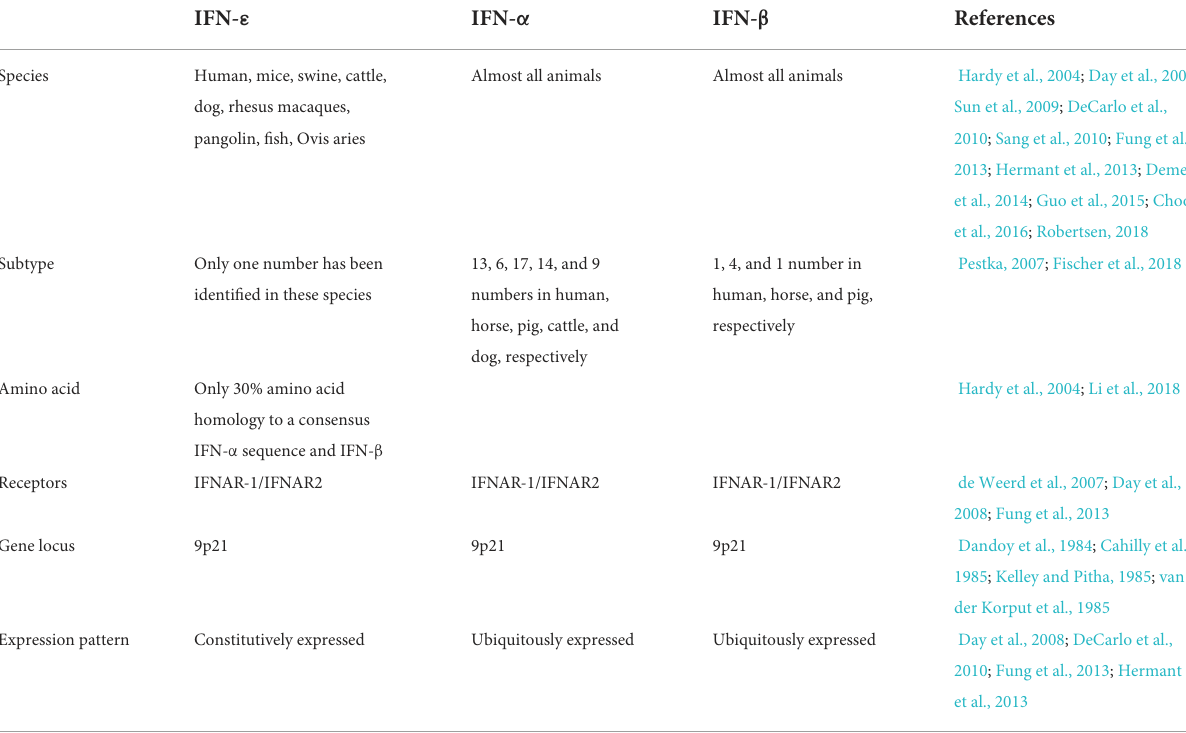
TABLE 2 IFN- ε gene expression in different tissues and cell